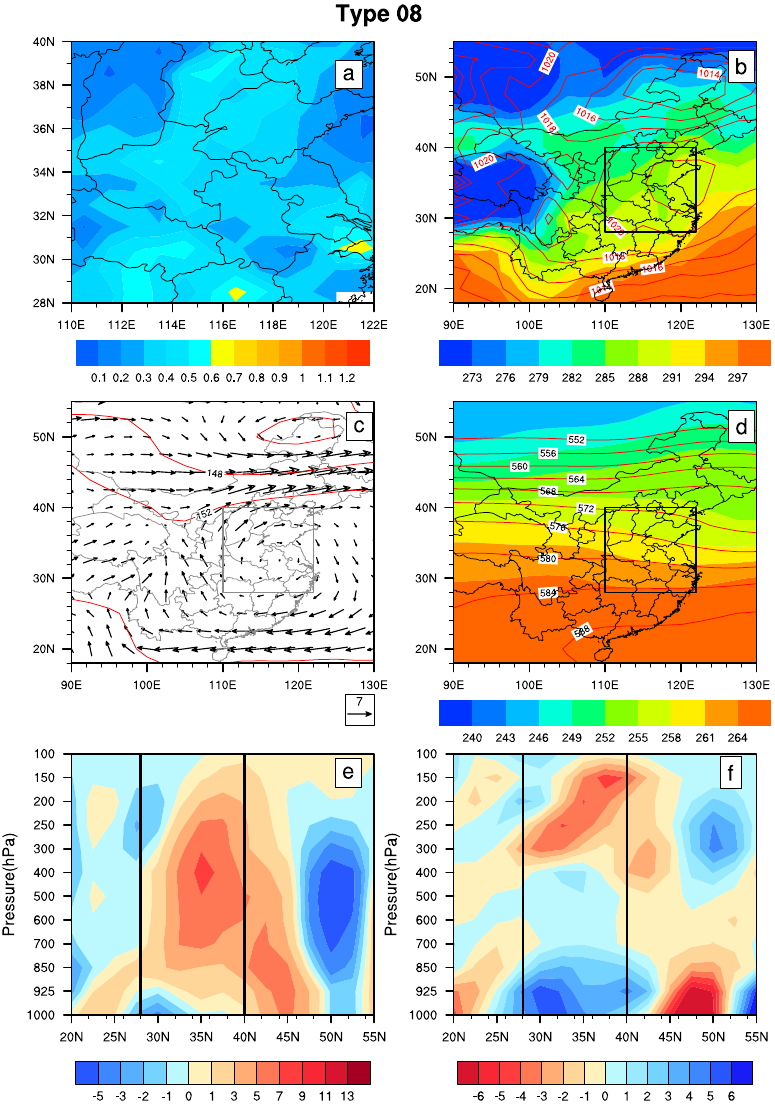
Figure 15. As in Fig. 8 but for Type 8